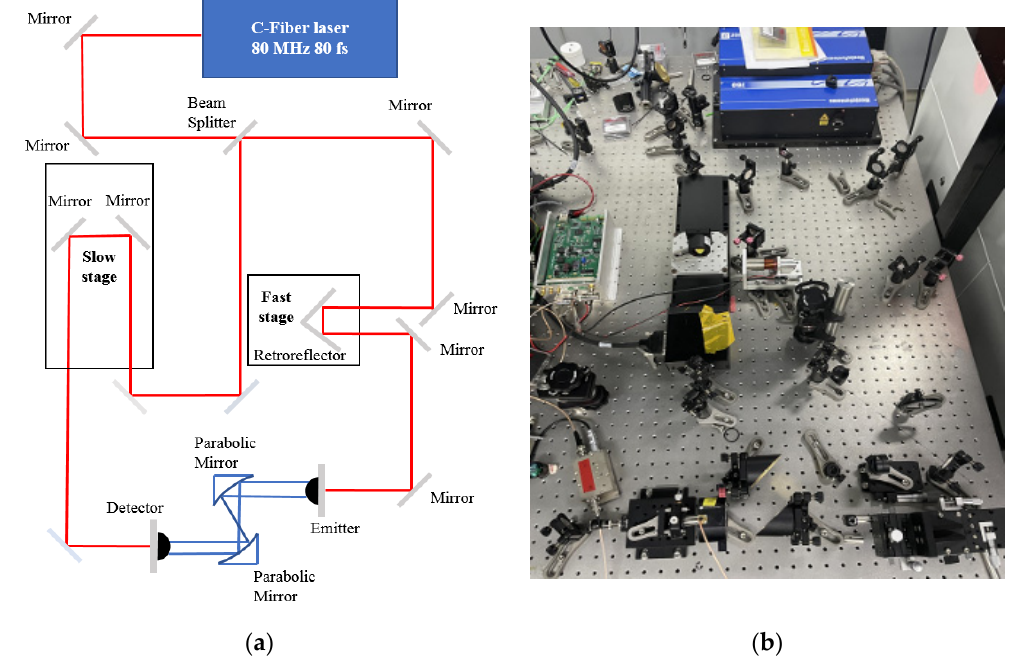
Figure 5. Measurement setup. ( a ) Schematic diagram; ( b ) photograph of the THz-TDS. To characterize the proposed PCA with saw-toothed plasmonic contact electrodes and conventional PCA, radiation signals were measured in response to an incident optical pump from a fiber-based femtosecond laser at a wavelength of 780 nm with a repetition rate of 80 MHz and a pulse width of 80 fs. The position of the circular pump spot was tuned to maximize the terahertz radiation. The measured THz radiation signals of the two prototype devices with a bias voltage of 40 V and an optical pump with a power of 20 mW are shown in Figure 6a. It can be observed that when the same optical pump power and